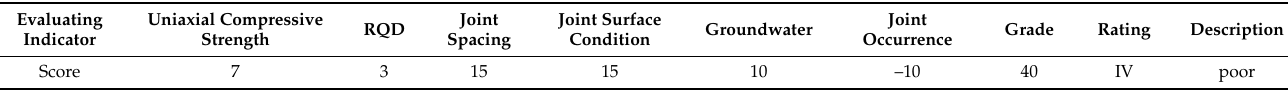
Table 3. Rock mass geomechanics classification (i.e., RMR).